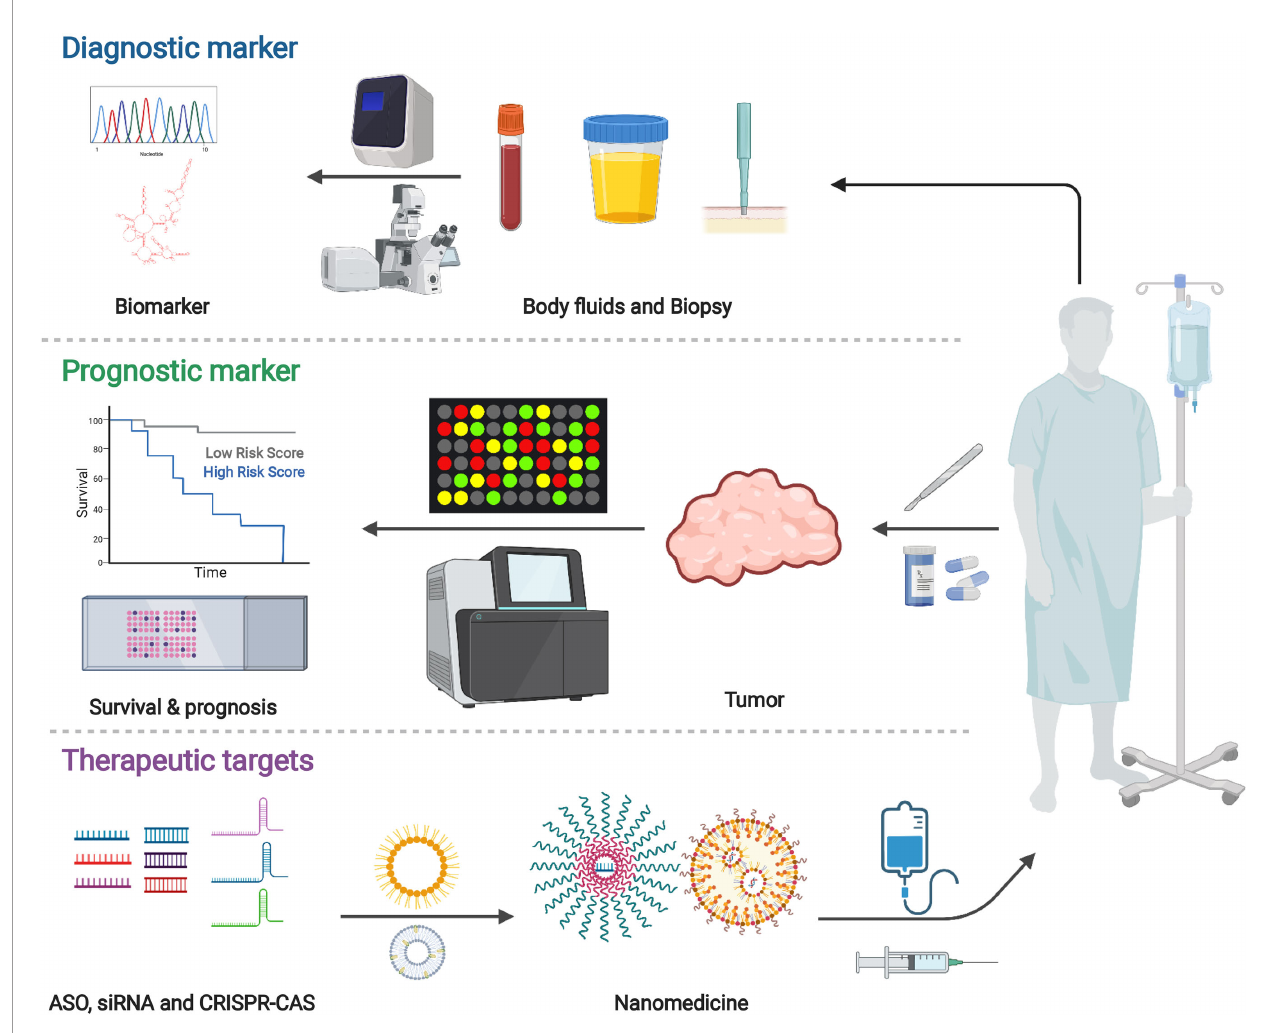
FIGURE 4 | Potential applications for cancer diagnosis and treatment. Various fi ndings demonstrated the importance and value of long non-coding RNAs. Studies highlighted the potential of lncRNA in biomarkers for cancer diagnosis and targets for cancer therapy. Created with